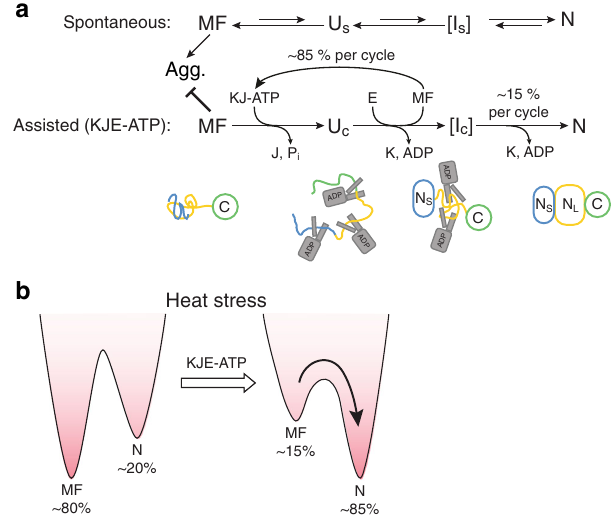
Fig. 9 Model of spontaneous and KJE-ATP assisted folding of FLuc. a MF, misfolded compact intermediate; Agg., aggregated protein; U S , unfolded state in the absence of chaperones; I S , folding intermediate of spontaneous folding; U C , unfolded state in complex with DnaK; I C , intermediate committed to fast folding; N, native state. Lengths of arrows re fl ects approximate relative rates. b Simpli fi ed energy diagrams to illustrate the effect of KJE-ATP in stabilizing the native state of FLuc at elevated temperature by accelerating refolding of